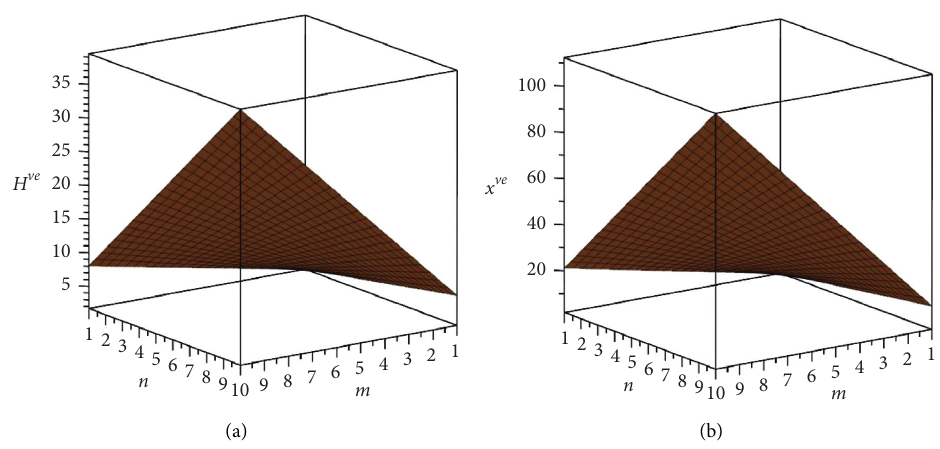
Figure 5: 3D plot of (a) H ve ( VC [ m, n ]) (b) χ ve ( VC [ m, n ])